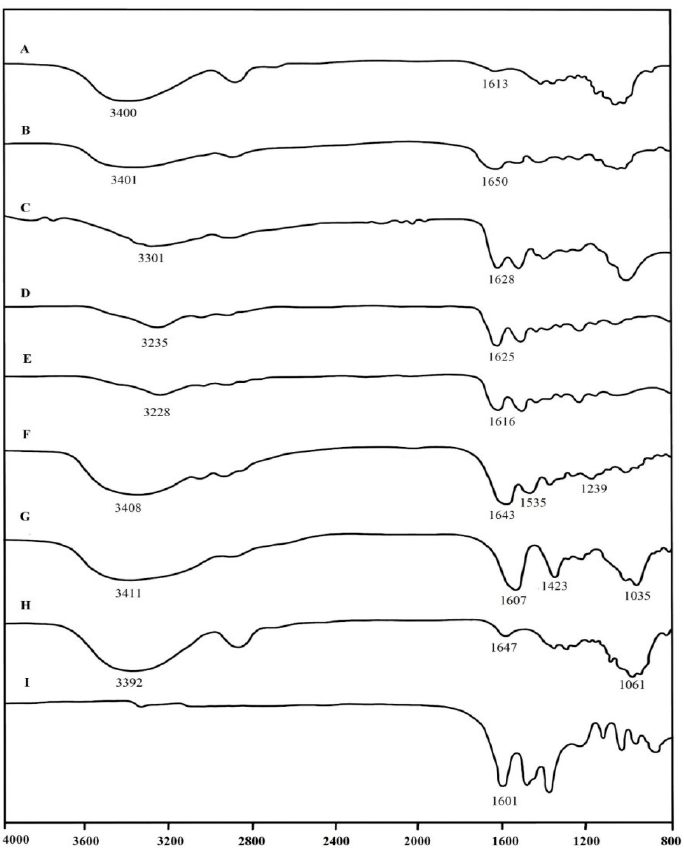
Figure 2. FT-IR spectra of: ( A ) BCAGG; ( B ) BCAGG-C1; ( C ) BCAGG-C2; ( D ) BCAGG-C3; ( E ) BCAGG-C4; ( F ) gelatin; ( G ) alginate; ( H ) BC; and ( I ) curcumin.